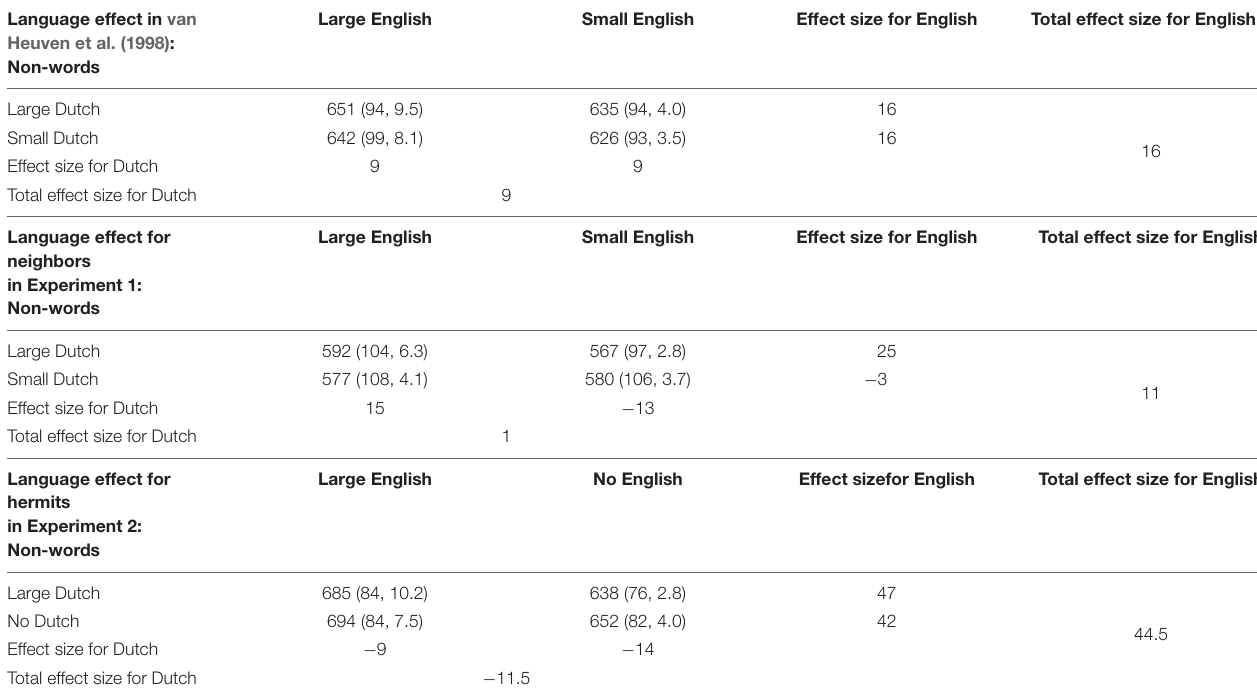
TABLE 3 | Mean RTs (in ms), standard deviations, error rates, and neighborhood effects for English non-word stimuli of English Lexical Decision in van Heuven et al. (1998, Experiment 4) and our replication study (Experiment 1), and Experiment 2 with hermits. Language effect in van Heuven et al. (1998):